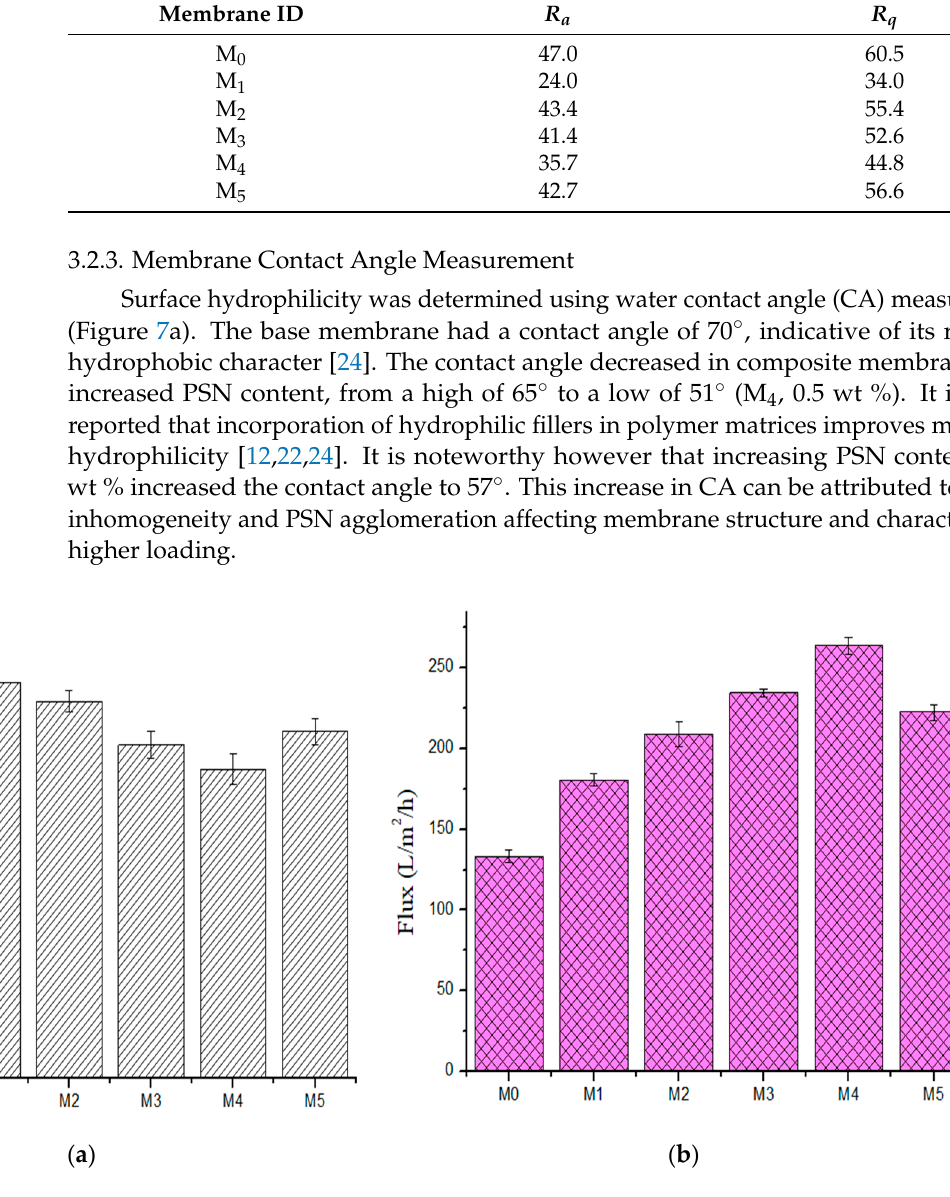
Figure 7. ( a ) Contact angle ( b ) pure water flux of fabricated membranes (M 0 ) 0.0 wt %, (M 1 ) 0.05 wt %, (M 2 ) 0.1 wt %, (M 3 ) 0.3 wt %, (M 4 ) 0.5 wt %, and (M 5 ) 1.0 wt %).